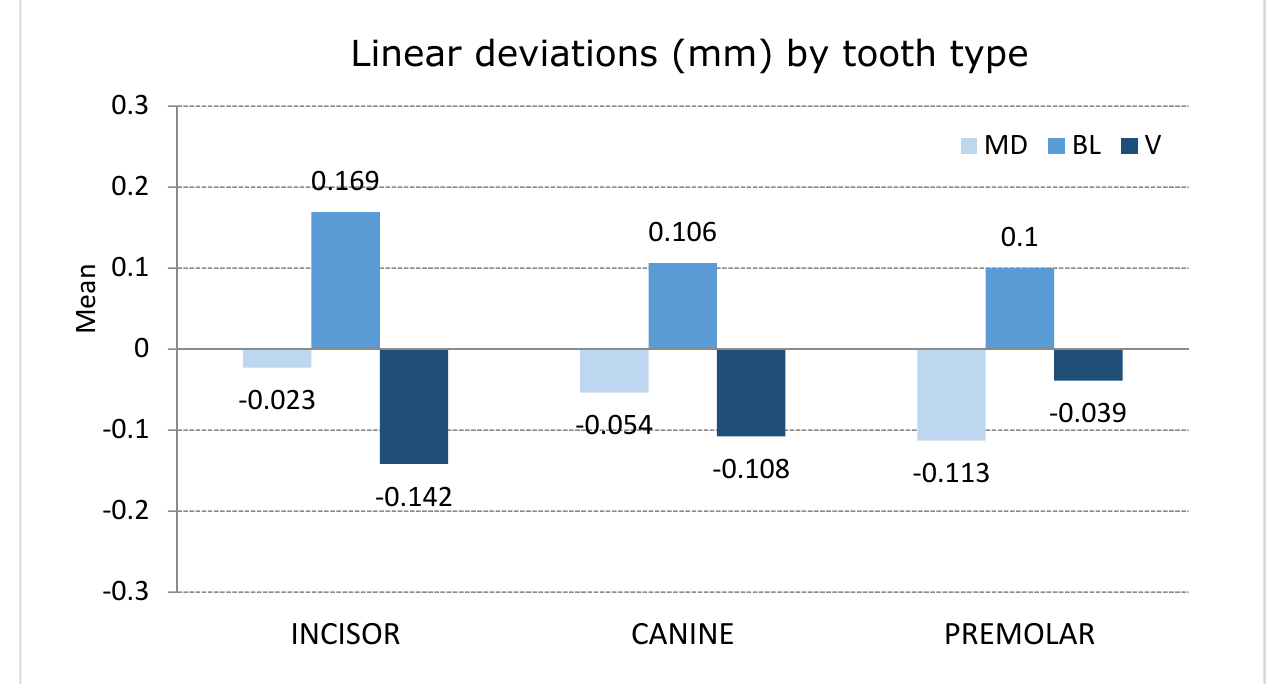
Figure 8. Plot of the mean values of the torque, tip, and rotation deviations of incisors, canines, and premolars. Incisors showed higher tip deviation values ( − 0.796 ± 0.805°) compared to canines ( − 0.434 ± 0.590°) and premolars (0.343 ± 0.795°) (Figure 8). Notably, the upper left lateral